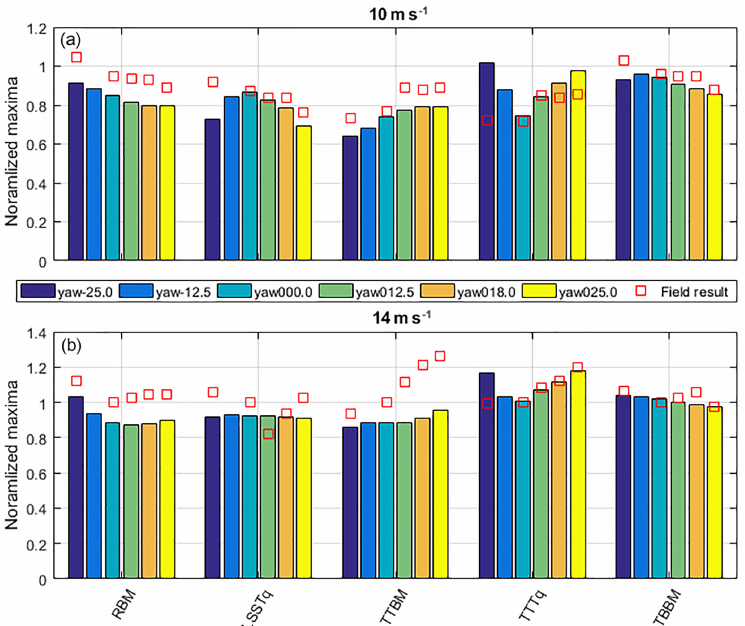
Figure 13. Comparison between predicted (FAST, bars) and measured (field, square symbols) mean extreme loads as a function of yaw offsets for mean U hub = 10ms − 1 (a) and 14ms − 1 (b) . The loads are normalized by their respective mean measured values at 0 ◦ yaw offset and U hub = 14ms − 1